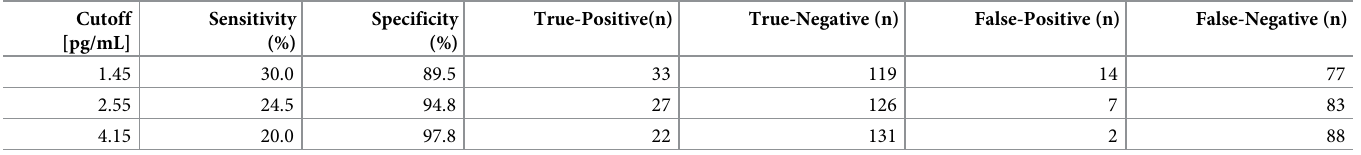
Table 1. Comparison of different cutoffs for the surviving